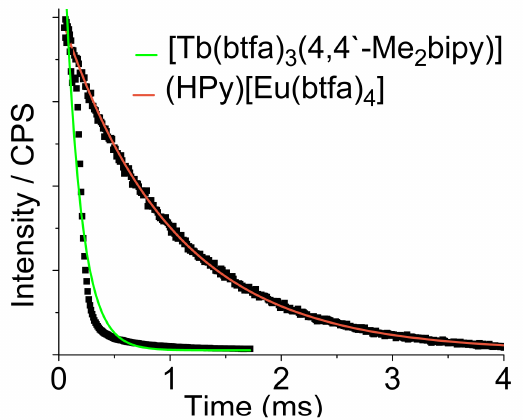
Figure 6. Excited state decay curves at room temperature for compound 9 and 10 in the microcrys- talline sample. Continuous lines represent the mono-exponential fittings of the